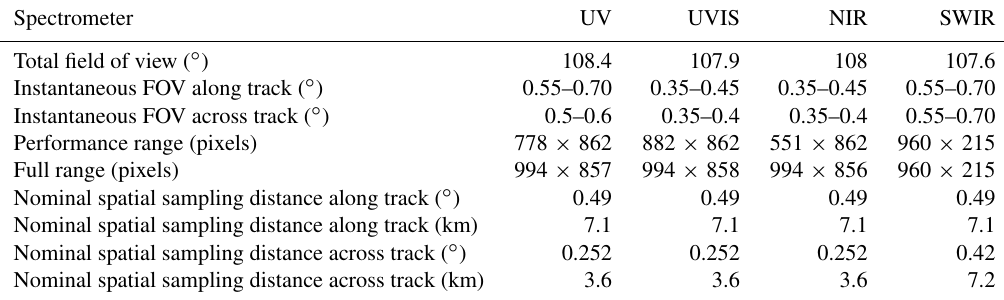
Table 2. Main geometrical performance parameters of each TROPOMI spectrometer. The listed nominal values are given at nadir for 1080ms of co-addition time and a row binning factor of 2 for bands 2–6. Band 1 is not shown; it has a row binning factor of 16 and the across-track sampling distance is 8 times higher than for bands 2 to 6. The pixel dimensions (spectral × spatial) include the spectral